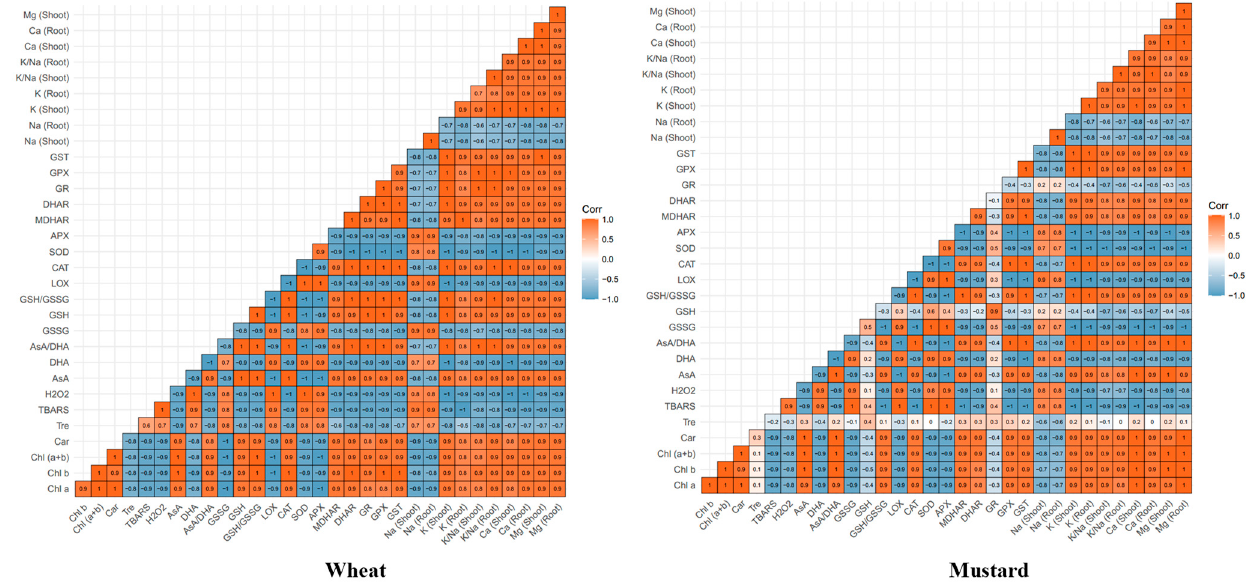
Figure 9. Pearson’s correlations between various parameters ( n = 32)of hydroponically grown nine − day − old wheat and ten-day-old mustard seedlings under salt (300 and 200 mM NaCl, respec- tively) and water deficit (20 and 12% PEG, respectively) stresses for four days with or without Tre and T6P. Chl (chlorophyll), Car (carotenoid), Tre (trehalose), TBARS (malondialdehyde), H 2 O 2 (hydrogen peroxide), AsA (ascorbic acid), DHA (dehydroascorbate), GSH (reduced glutathione), GSSG (oxi- dized glutathione), LOX (lipoxygenase), CAT (catalase), SOD (superoxide dismutase), APX (ascorbate peroxidase), MDHAR (monodehydroascorbate reductase), DHAR (dehydroascorbate reductase), GR (glutathione reductase), GPX (glutathione peroxidase), GST (glutathione S -transferase), Na (sodium), K (potassium), Ca (calcium), and Mg